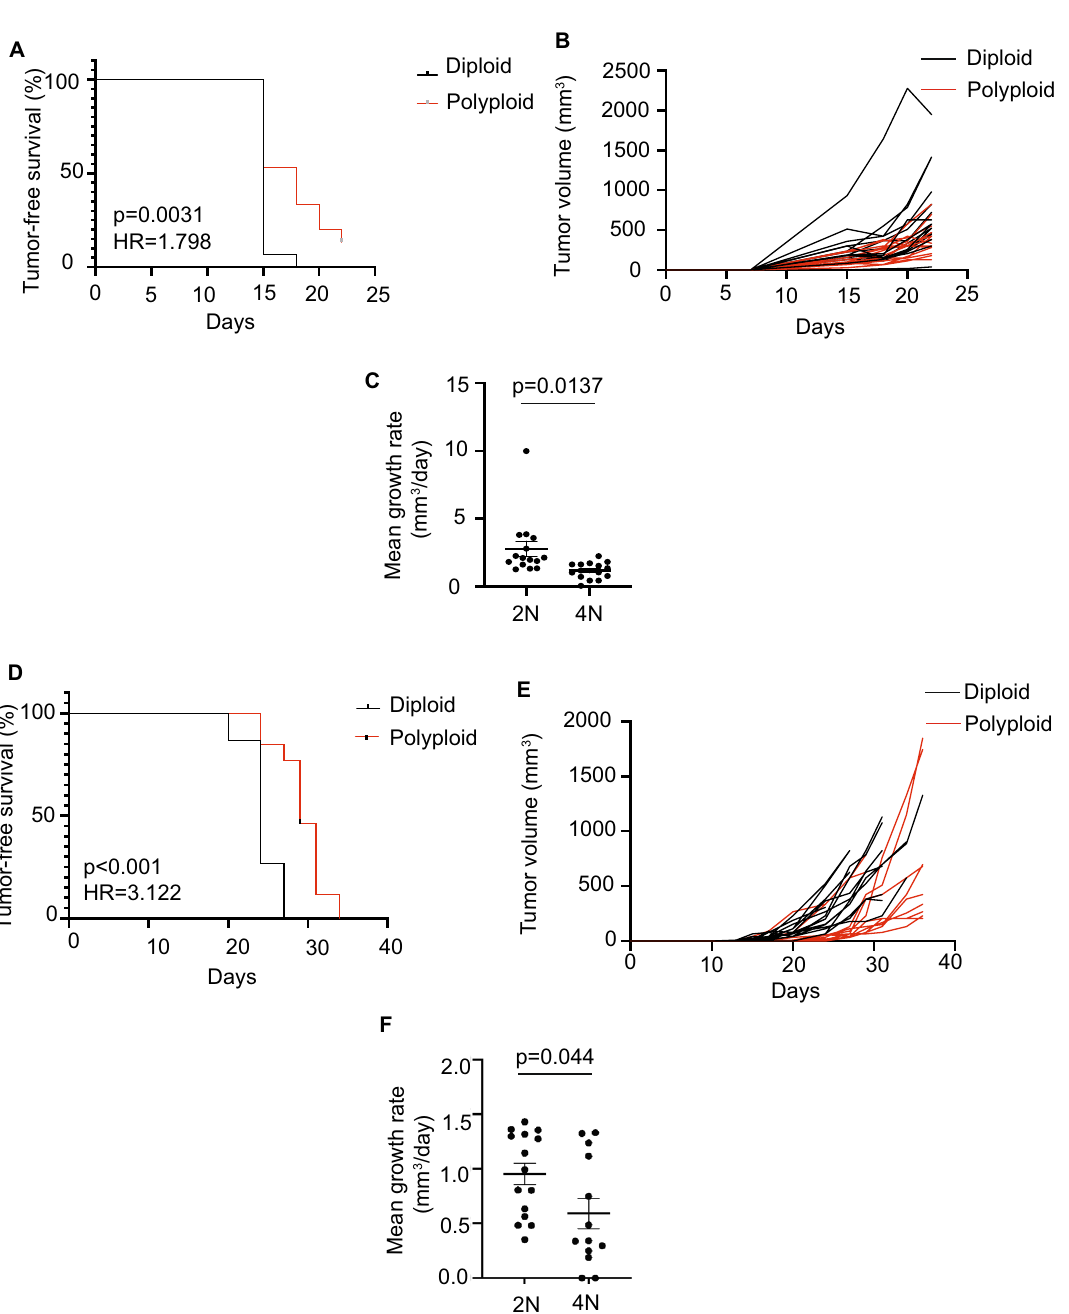
Figure 4. Polyploid recurrent tumors exhibit a growth defect relative to diploid tumors. ( A ) Kaplan–Meier plot showing tumor-free survival for mice injected with diploid or polyploid tumor cells from the spontaneous model. Hazards ratio (HR) and p value were determined using a log-rank test. ( B ) Tumor growth curves for diploid and polyploid tumors from the spontaneous model. ( C ) Mean growth rate for diploid and polyploid tumors from the spontaneous model. Significance was determined using Welch’s t-test. ( D ) Kaplan–Meier plot showing tumor-free survival for mice injected with diploid or polyploid tumor cells from the induced model. Hazards Ratio (HR) and p-value were determined using a log-rank test. ( E ) Tumor growth curves for diploid and polyploid tumors from the induced model. ( F ) Mean growth rate for diploid and polyploid tumors from the spontaneous model. Significance was determined using Welch’s t-test. ( A – F ) were generated using Graph Pad Prism 9 software (version 9.0.0 (86) for Mac, https:// www. graph pad. com/ scien tific- softw are/